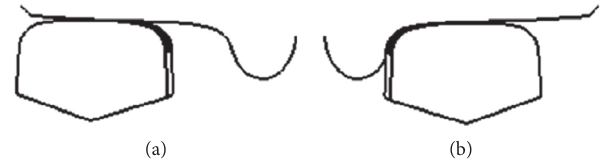
Figure 12: Wheel-rail contact relationship. (a) Inner rail. (b) Outer rail.